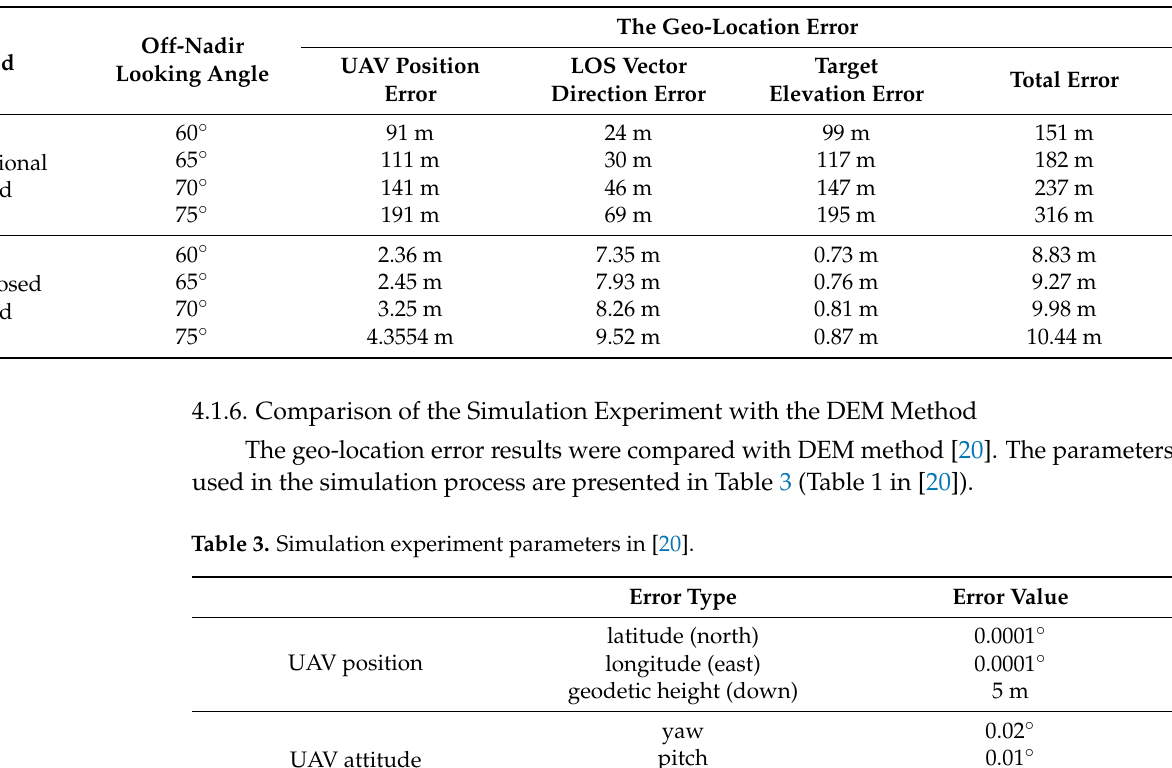
Table 2. Geo-location error results of the proposed method and the traditional method.